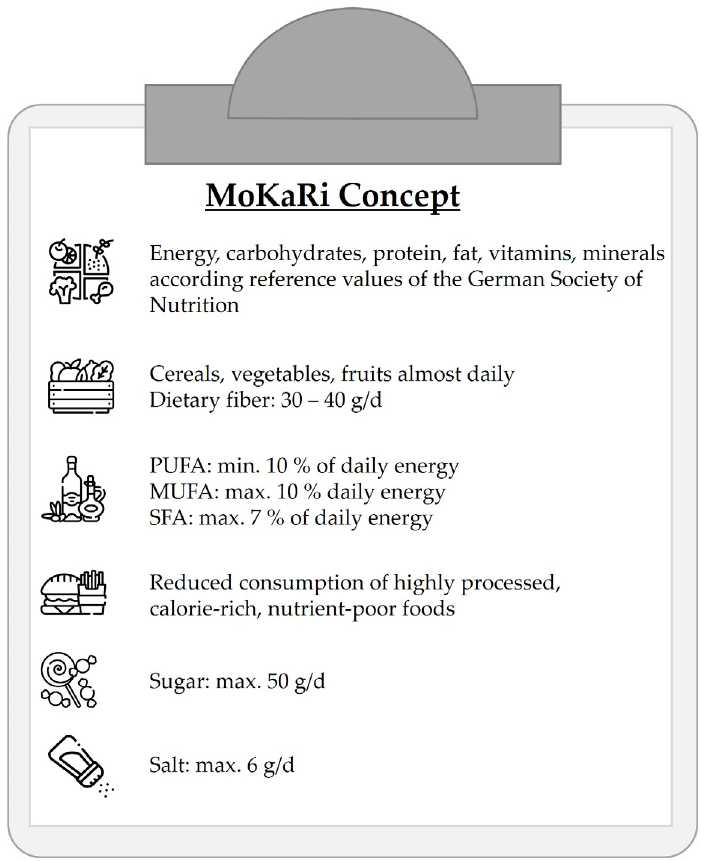
Figure 2. Criteria of the MoKaRi concept (MUFA, monounsaturated fa tt y acids; PUFA, polyunsaturated fa tt y acids; SFA, saturated fa tt y acids).